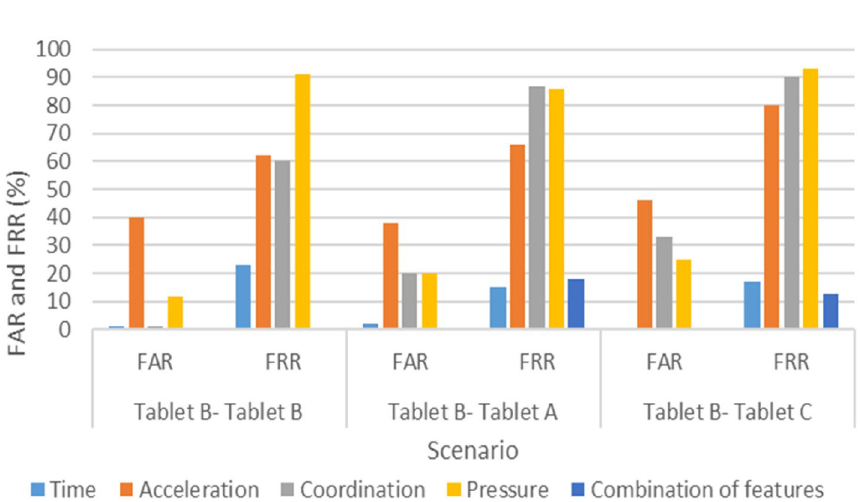
Figure 5. FAR and FRR of Scenario 2 (Tablet B–Tablet B, Tablet B–Tablet A, and Tablet B–Tablet C).